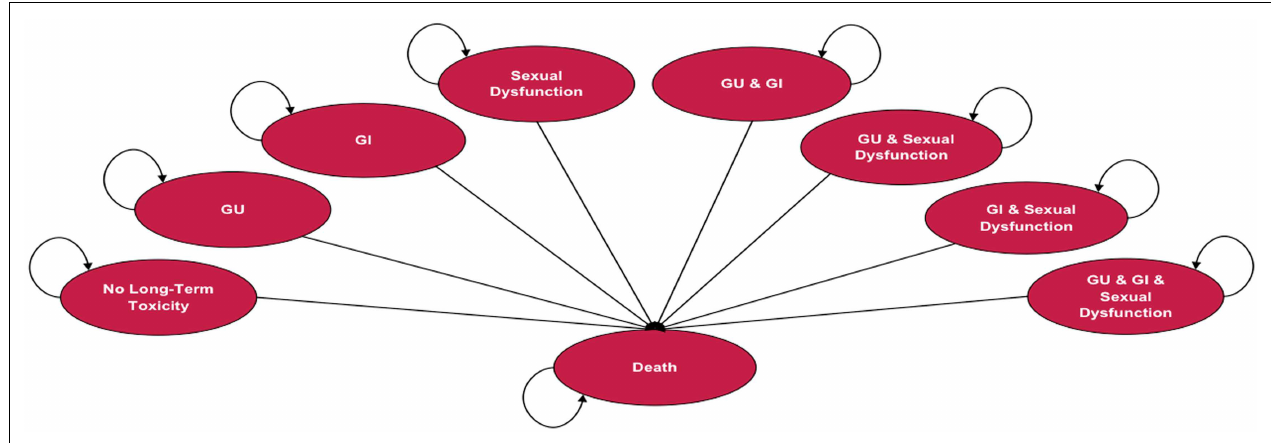
FIGURE 1 | Markov model. GI, gastrointestinal; GU, genitourinary; SD, sexual